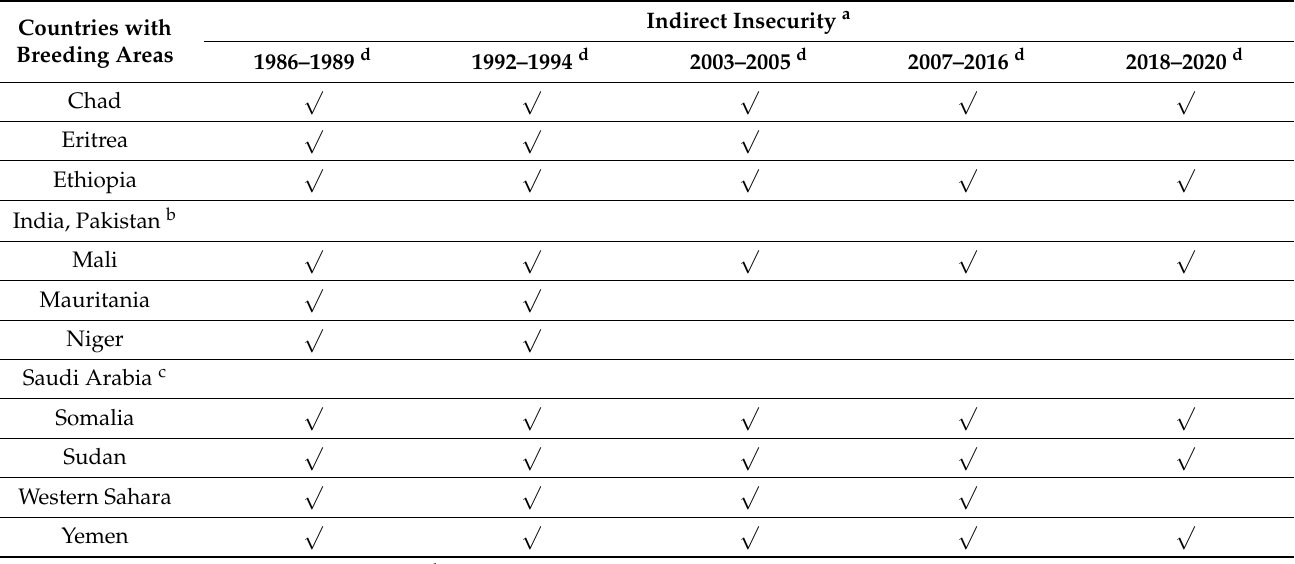
Table 2. Thirteen countries with major desert locust breeding areas, and where indirect insecurity occurred during different time